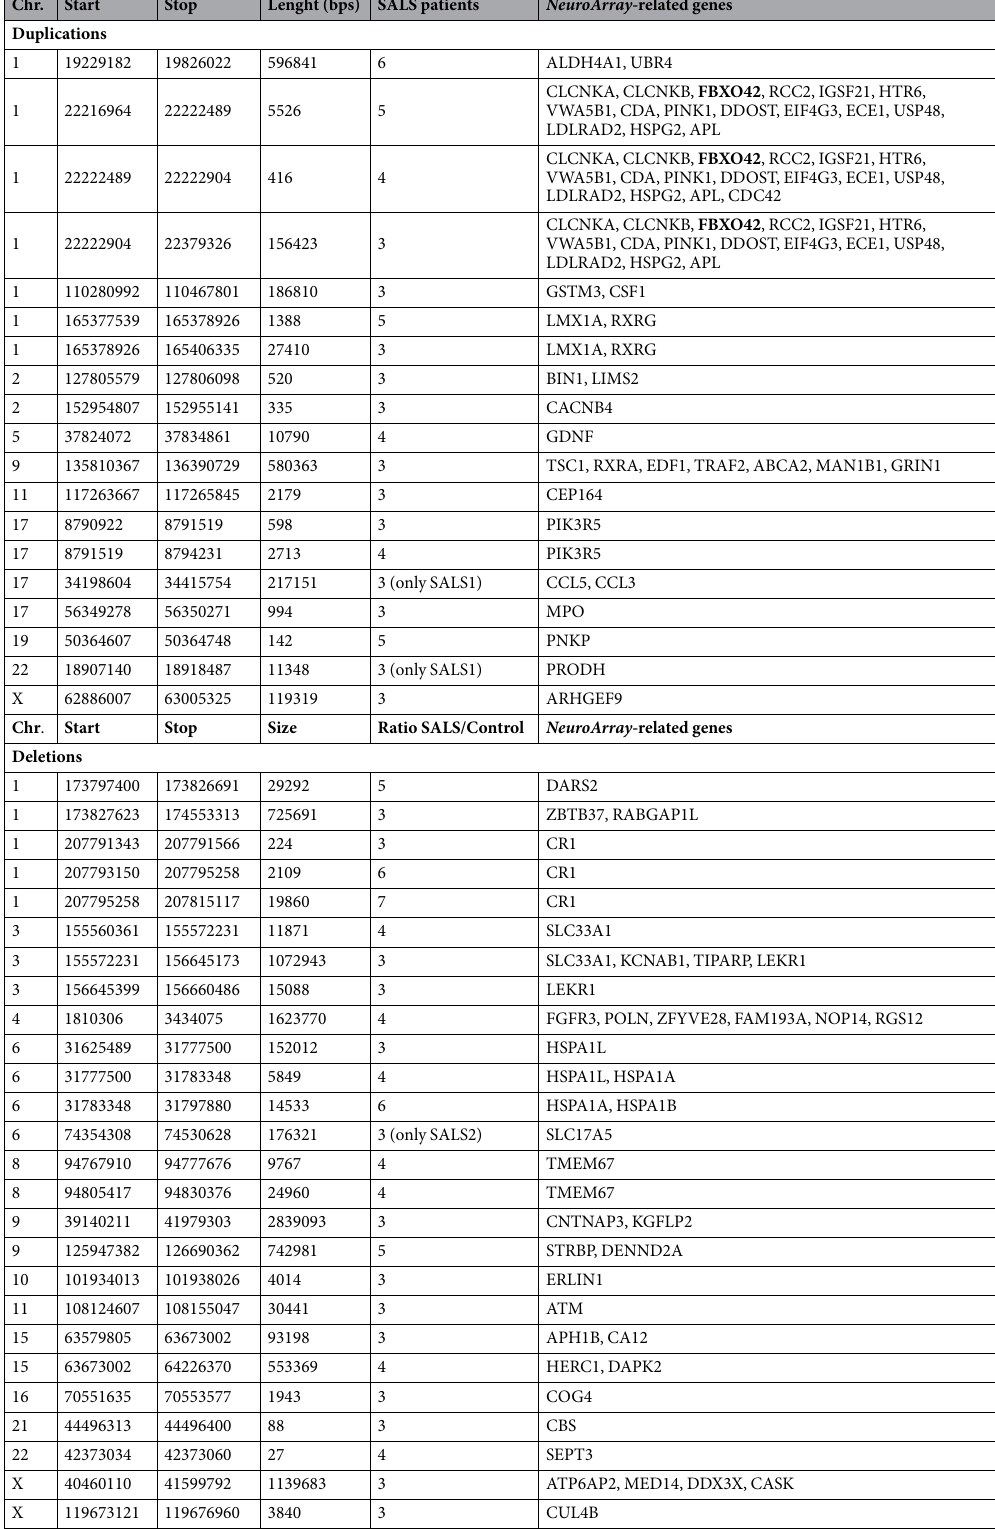
Table 2. Chromosomal distribution of the most frequent CNVs exclusively detected in SALS patients. The table lists the duplications and deletions that occurred in at least 10% of SALS patients and absent in the control samples. The chromosomal regions, including the start and end positions, number of SALS patients and CNV embedded NeuroArray genes are listed. Chromosomal positions are referred to the human reference sequence hg19 assembly. Genes previously identified as potential risk factors in ALS are in